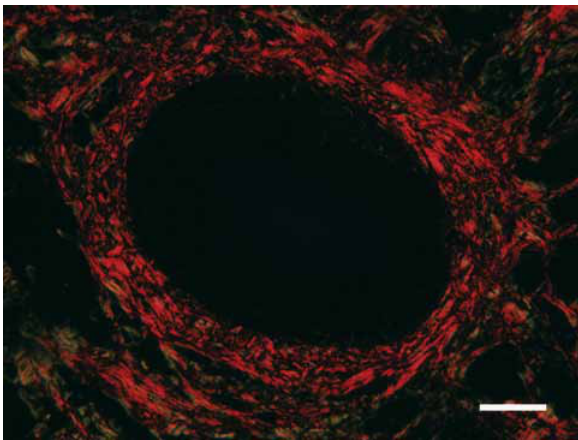
Figure 5 - Collagen arrangement in the tunica adventitia of the DAP of rabbits from the control group. Sections were stained with Picro Sirius red stain, and images were taken using polarized light at 400x magnification. Scale bar: 50µm.